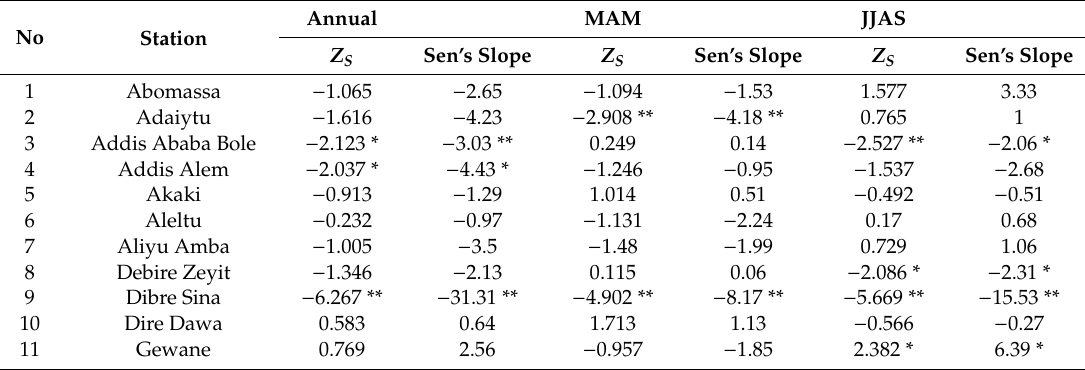
Table 3. Summary of rainfall trend test using Mann–Kendall and Sen’s Slope in